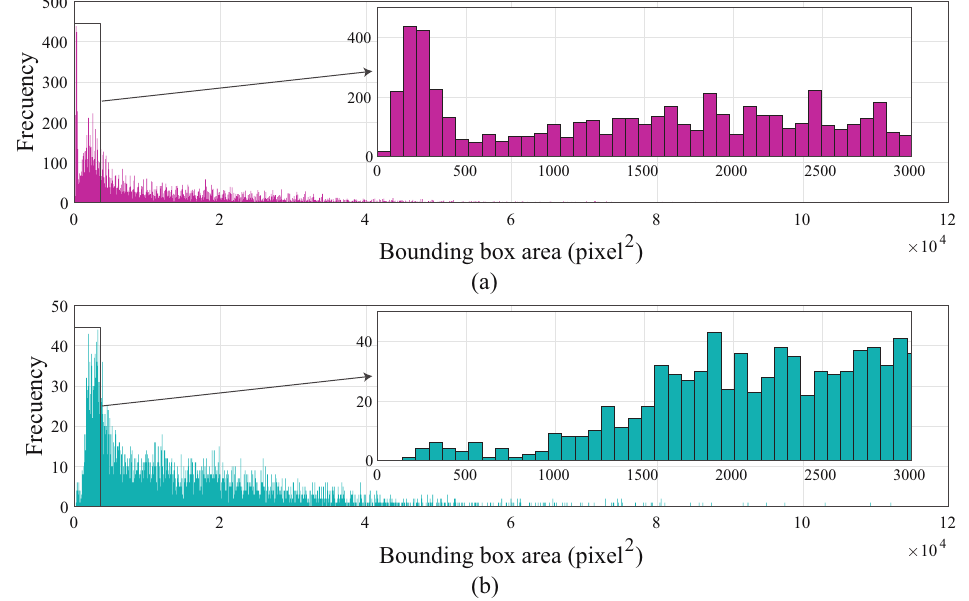
Figure 6. Histogram of bounding box area. ( a ) Ground-truth, and ( b ) cherries detected in the validation and testing